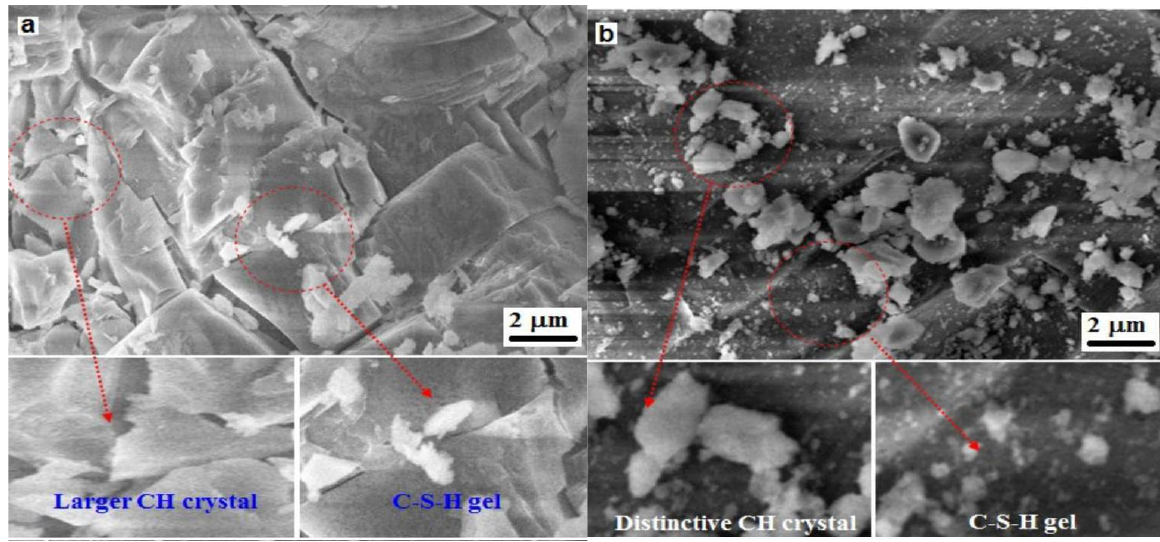
Figure 13. SEM image of concrete powder samples ( a ) NW with 1% optimized of SP ( b ) MW with 0% SP.